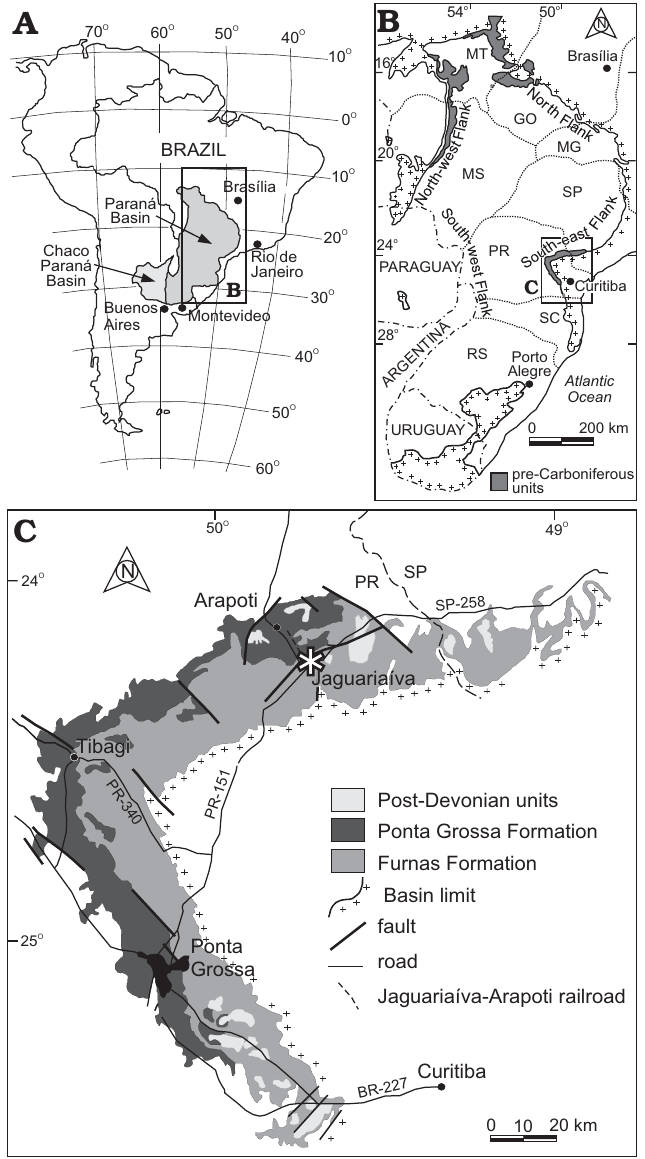
Fig. 1. A . Geographic location of the relevant geological sections within Paraná State, Brazil. B . Map showing the outcrop belt of the Lower Devonian Ponta Grossa Formation on the eastern margin of the Paraná Basin (from Simões et al. 2009). C . Geological map of the study area with Jaguariaíva